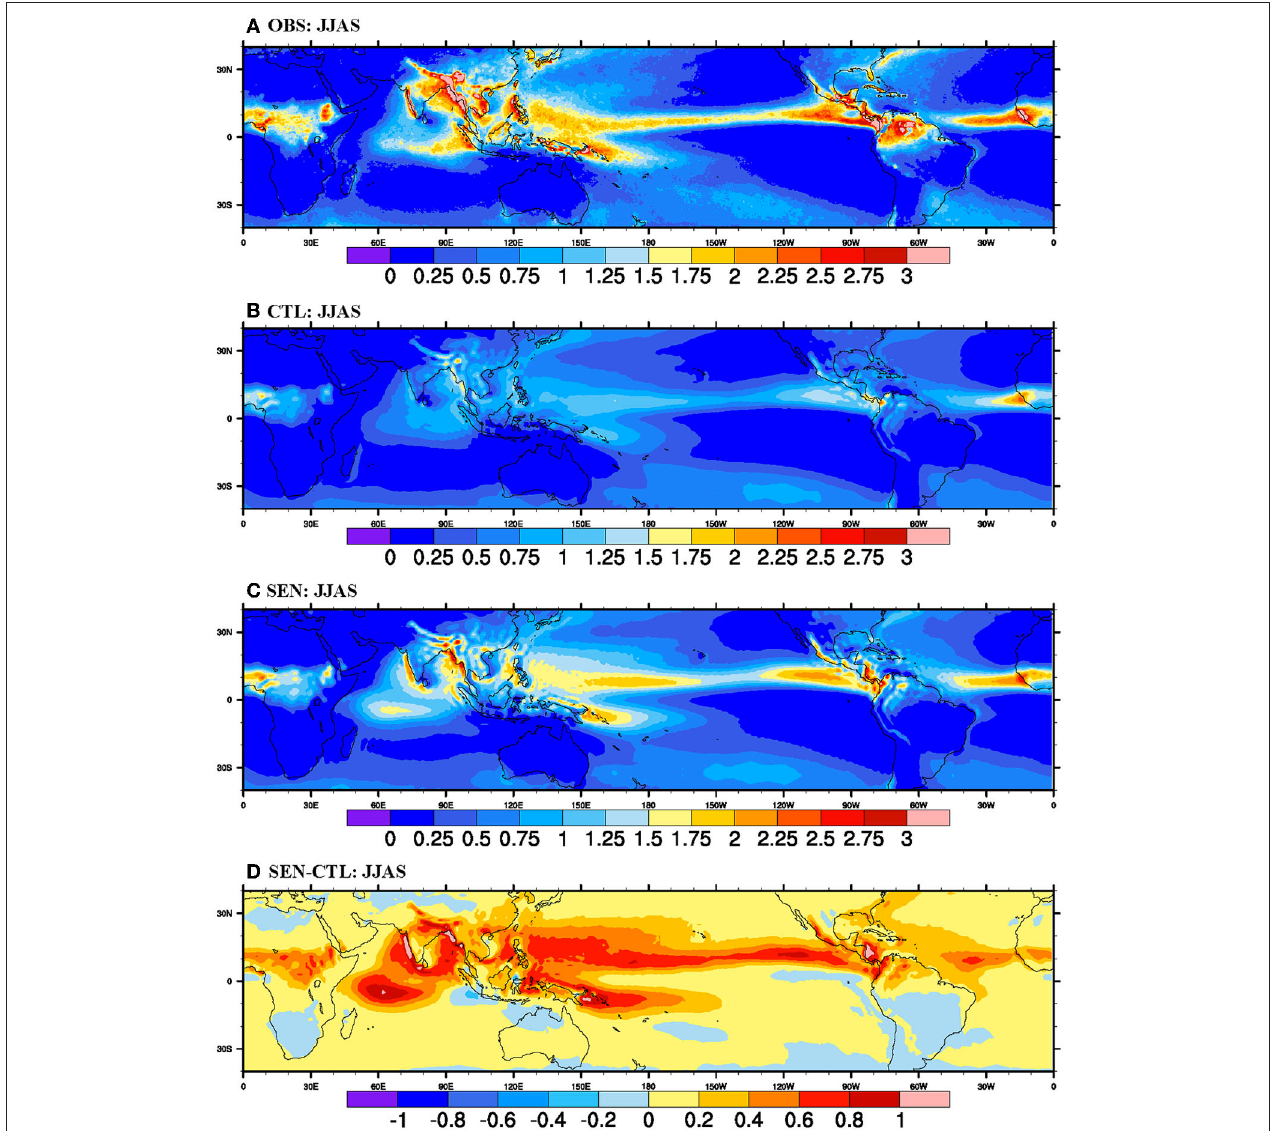
FIGURE 3 | Seasonal (JJAS) Mean diurnal range of prate ( dPRATE = maximum-minimum during 24-h cycle in mm/h) from (A) observation (TRMM), (B) CTL, (C) SEN run, and (D) SEN minus CTL for the period